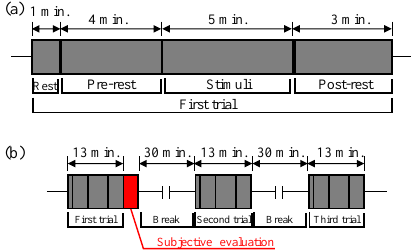
Figure 1. Experimental processes ( a ) for each of the trials and ( b ) for the entire experiment.